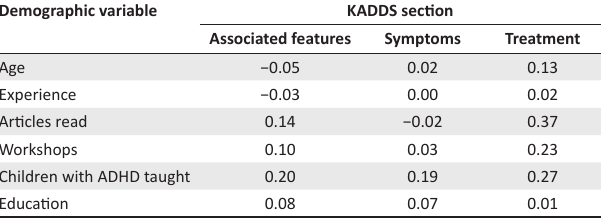
TABLE 2: Pearson’s correlation coefficient for demographic variable with Knowledge of Attention Deficit Disorders Scale